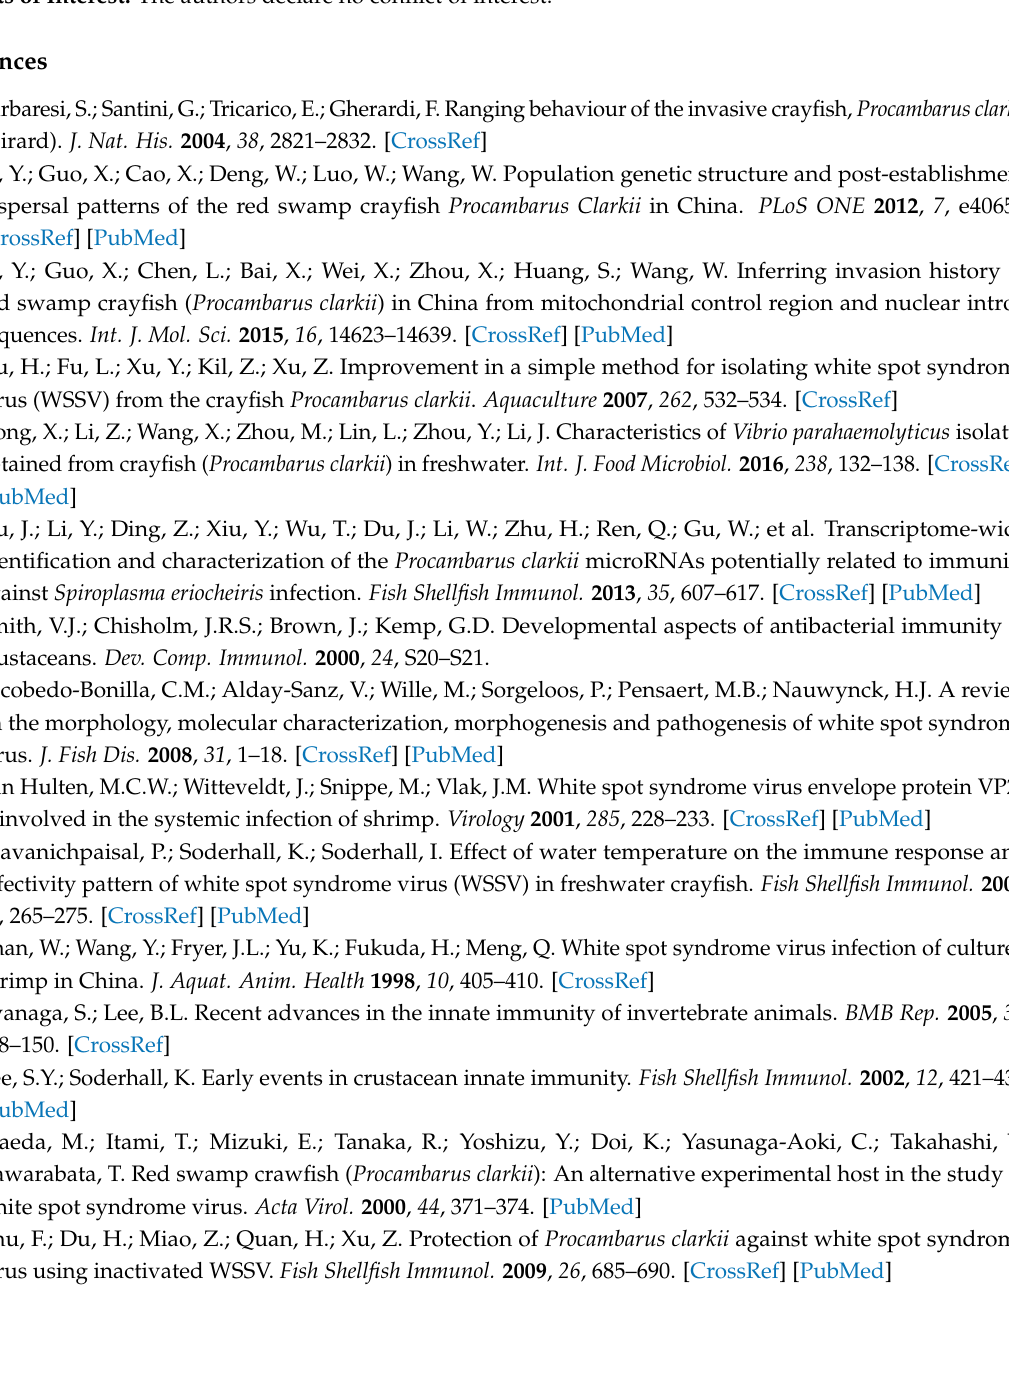
Table S1: The primer sequences of the selected genes for qRT-PCR, Table S2: The list of differentially expressed genes identified in the pairwise comparisons, Figure S1: The length distribution of the assembled unigenes, Figure S2: The GO enrichment of the DEGs in GS vs. GC and GR vs. GC, Figure S3: The enriched KEGG pathway in GS vs. GC and GR vs.